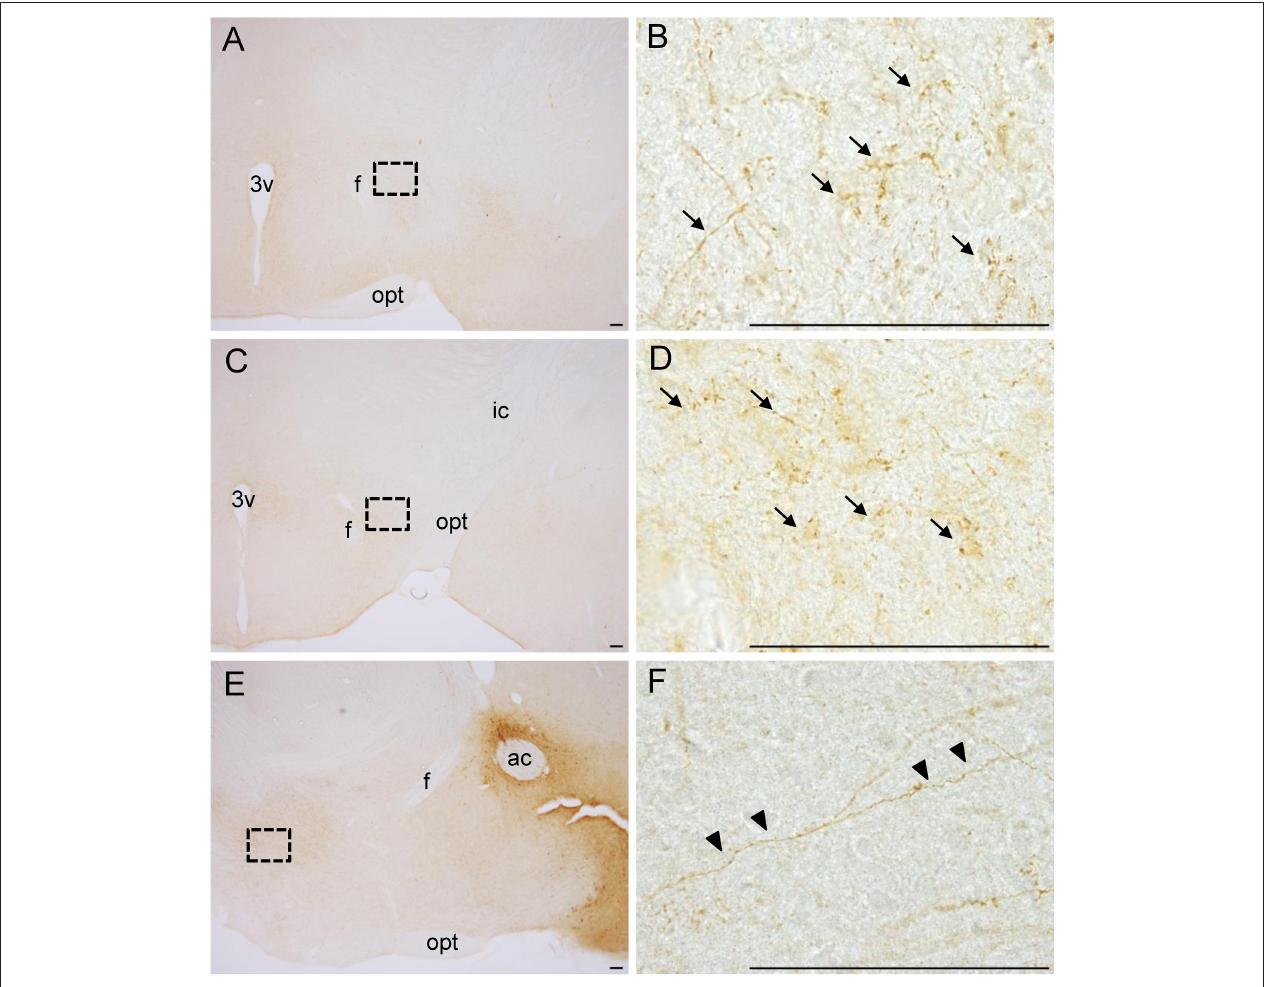
FIGURE 2 | Photographs of dot-like mCherry-expressing fibers (arrows) from the NAc in the anterior part (A, B) and posterior part (C, D) of the LH in coronal sections. In sagittal sections (E, F) , mCherry-expressing fibers from the NAc to the LH are shown (arrowheads). The regions in the black square boxes in A, C, and E are magnified in B, D, and F , respectively. Scale bars, 100 µ m. ac, anterior commissure; f, fornix; ic, internal capsule; opt, optic tract; 3v, third ventricle.